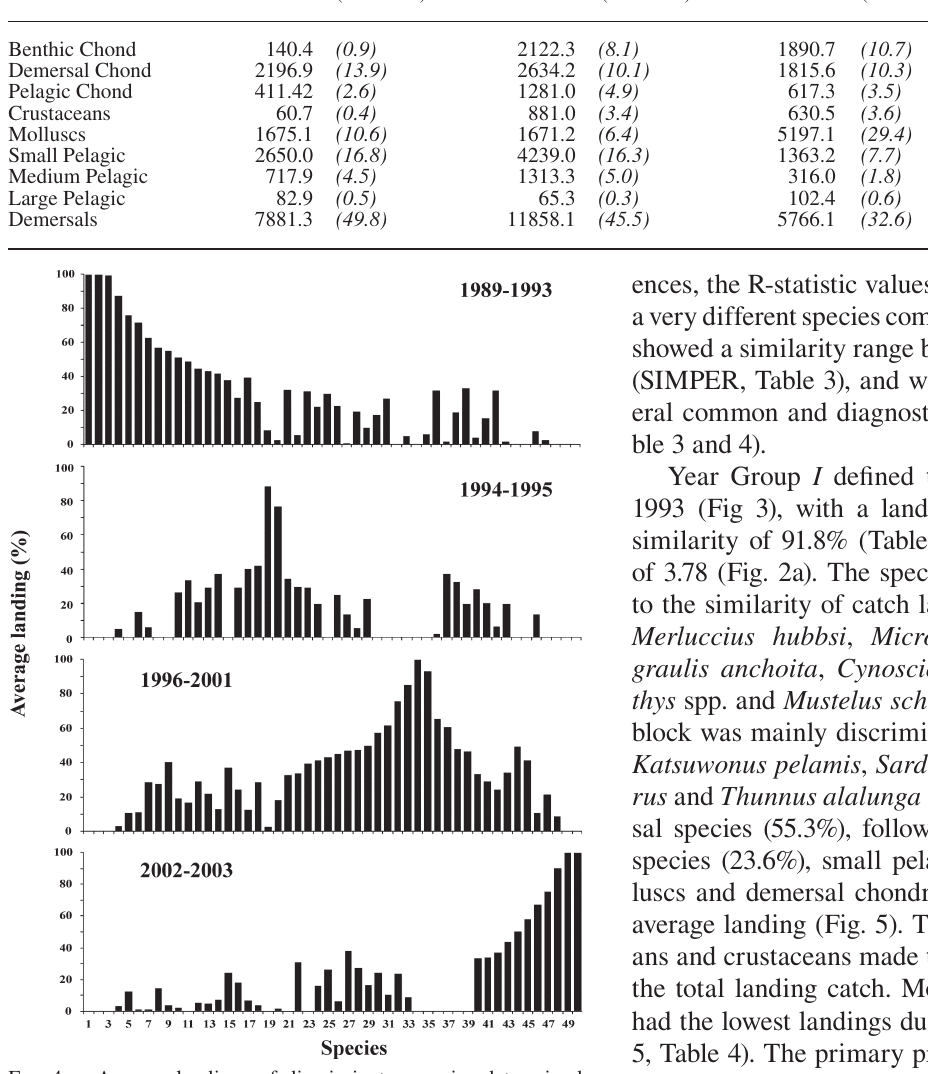
f ig . 4. – Average landings of discriminator species determined using siMPer for each time block. 1, Cottoperca gobio ; 2, Car- charhinus plumbeus ; 3, Katsuwonus pelamis ; 4, Sarda sarda ; 5, Pleoticus muelleri ; 6, Seriola lalandi ; 7, Thunnus alalunga ; 8, Pseudopercis semifasciata ; 9, Farfantepeneaus paulensis ; 10, Odontesthes spp.; 11, Carcharias taurus ; 12, Brevoortia spp.;